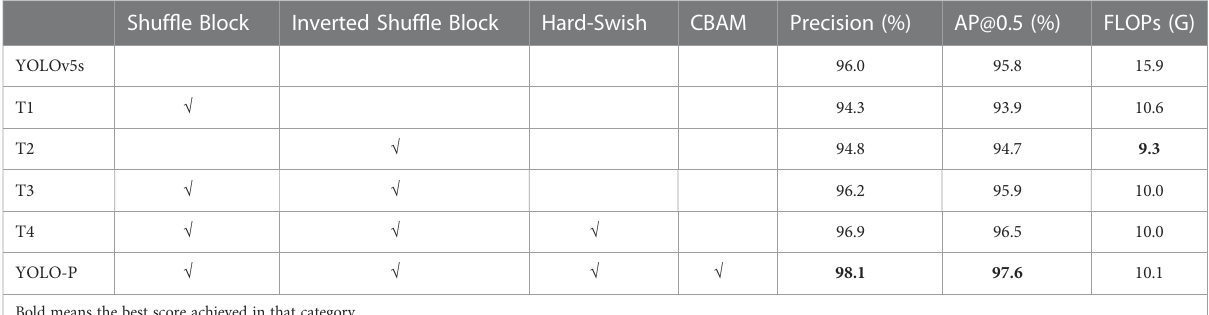
TABLE 4 Results of ablation experiments.